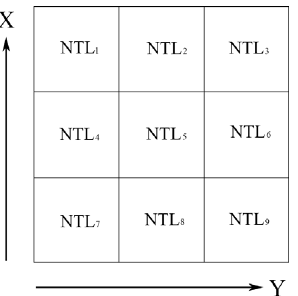
Figure 2. Schematic diagram of the brightness gradients.